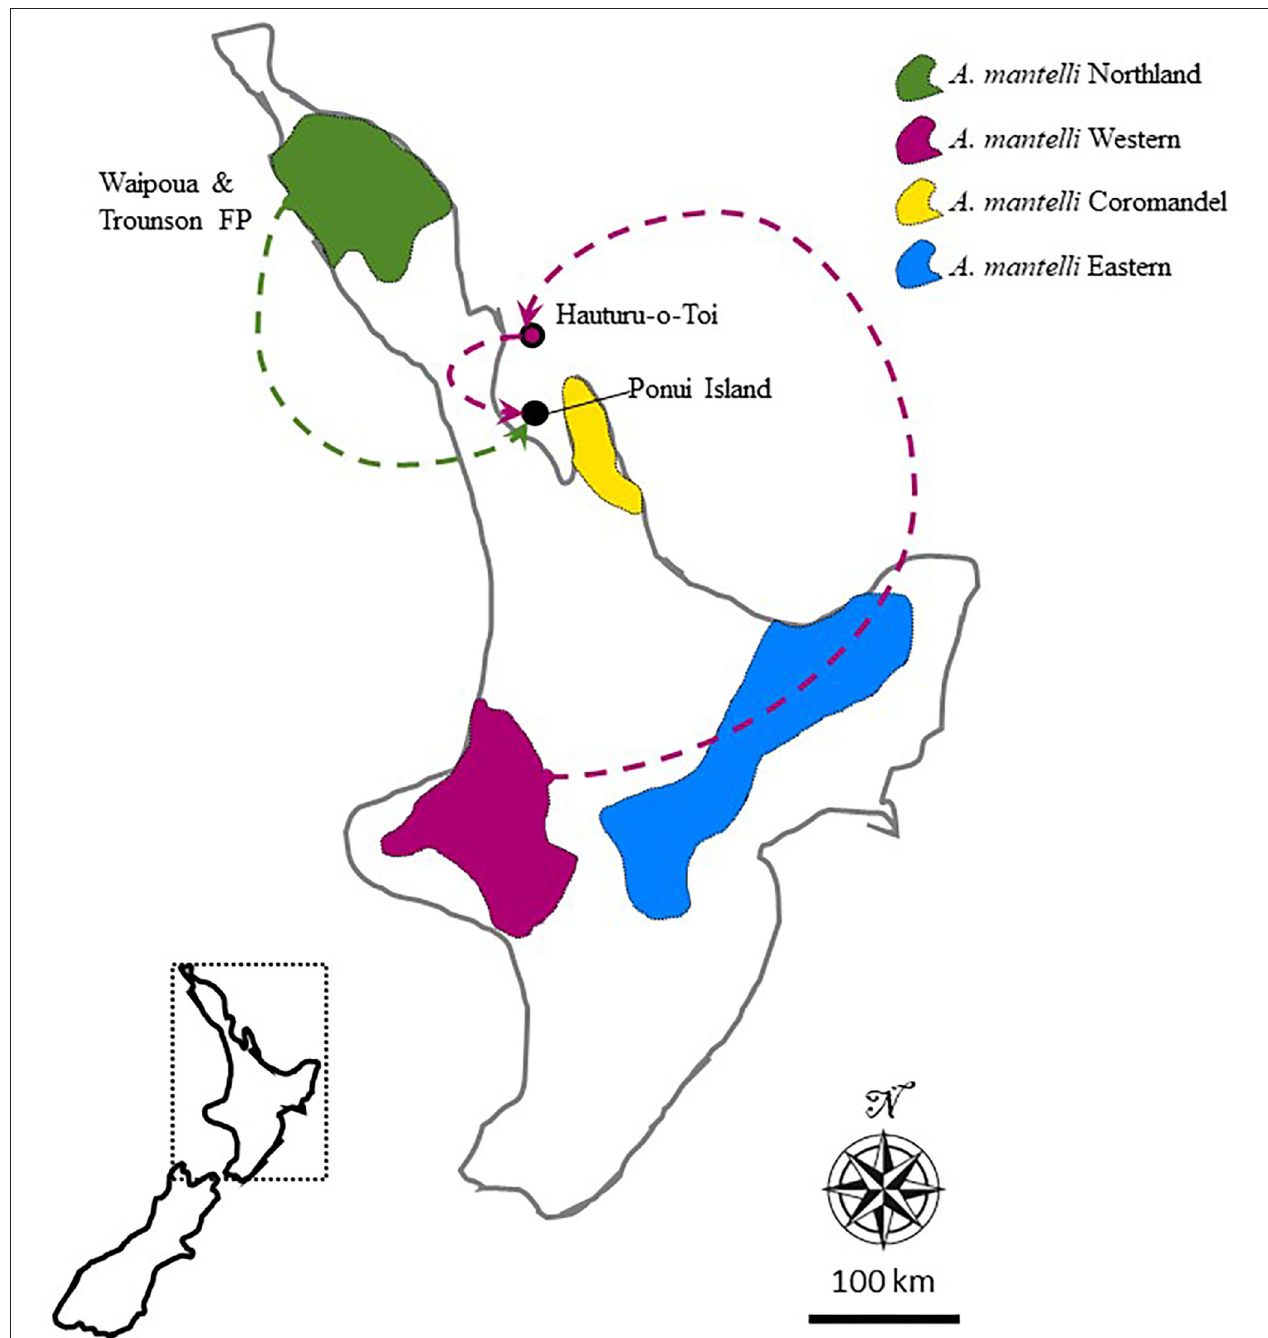
FIGURE 1 | Map of New Zealand’s North Island illustrating the approximate distribution of the four management units (also referred to as taxa) recognised within this species. The location of Ponui Island, its parental populations, and the origin of the Hauturu birds are indicated. Modified from Undin et al. (2021b).